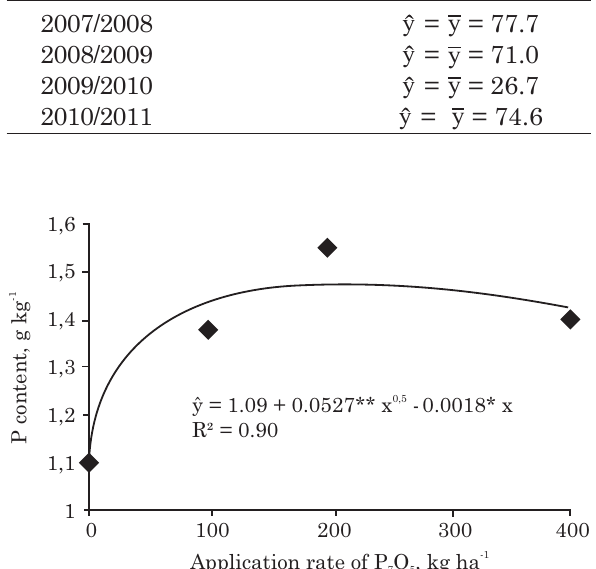
Figure 2. Mean leaf content of P as a function of rates of P 2 O 5 applied as a mean value for the four sources of P used in the 2010/2011 crop season. ** and *: significant at 1 and 5 %,